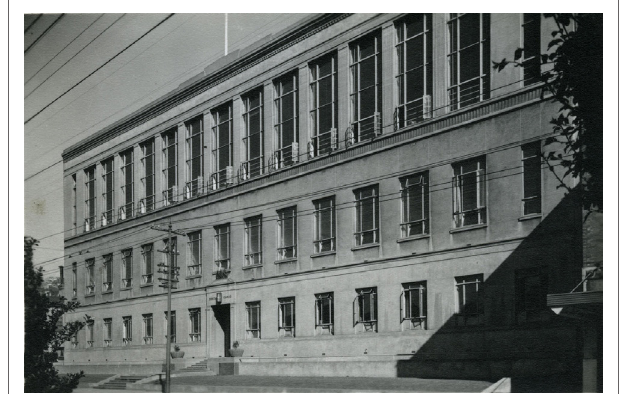
FiguRe 5 | The Dominion School for Dental Nurses, Willis Street, Wellington, 1940 [Archives New Zealand/Te Rua Mahara o te Kawanatanga, Wellington Office (Archives Reference: ABKI 667/3)]. “In many ways its imposing structure made it appear like a temple of the welfare state. Solid, large and built to allow the most efficient use of space, it symbolised in architectural form the ideal of a benevolent, centralised State social service” (17).